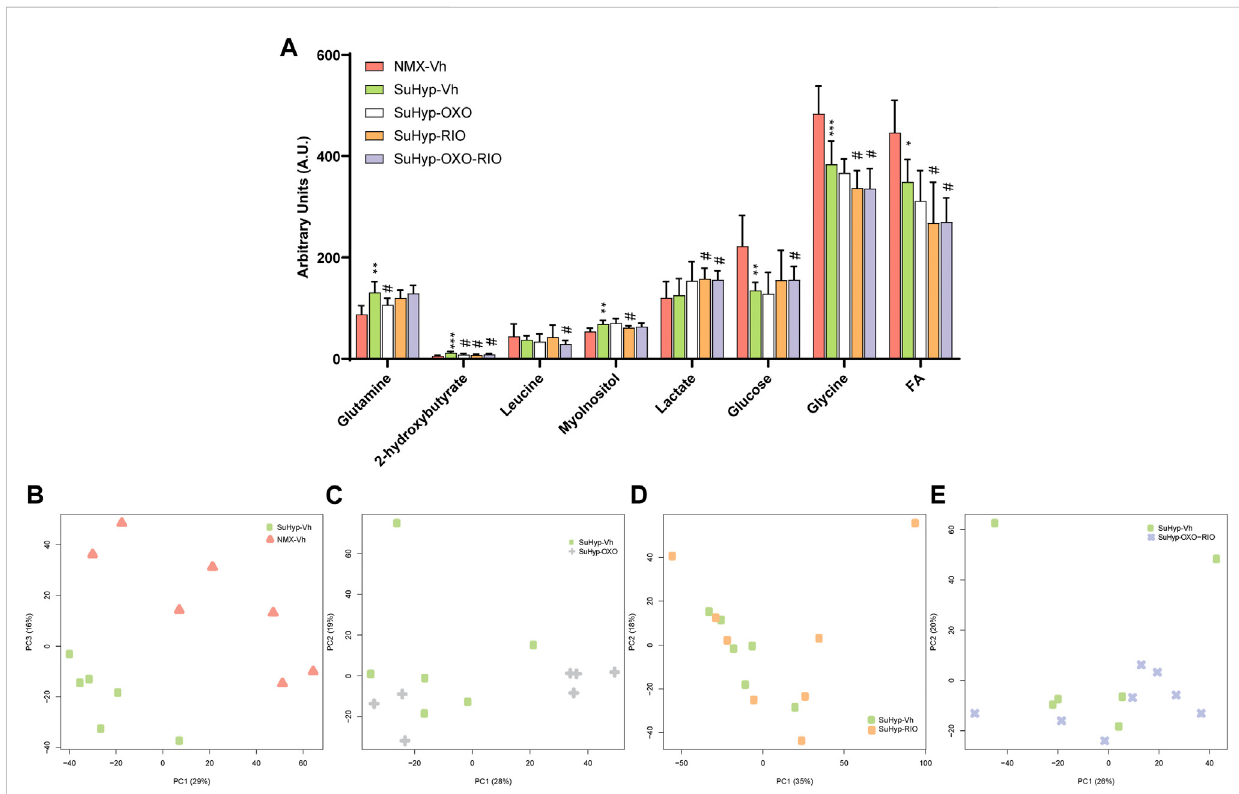
FIGURE 5 Treatment with riociguat and 5-z-7oxozeaenol has a modest effect on the lung metabolic reprogramming in the SuHyp rats. (A) Metabolomic pro fi ling of lung samples showing the quanti fi cation of metabolites signi fi cantly altered between the fi ve intervention groups. Statistical signi fi cance was determined usingaBonferroni-correctedStudent ’ st-test(* p < 0.05 versus normoxiavehicleand# p < 0.05 versus SuHypvehicle). (B) Metabolicpro fi ling of lung samples discriminated between SuHyp and control groups as shown by principal components analysis (PCA) performed on 1 H-MRS data. Treatment with (C) 5Z-7-oxozeaenol, (D) riociguat or (E) both drugs induced a modest effect on the metabolic changes observed in the lungs from SuHPX rats. Control group: NMX-Vh, Sugen 5,416/hypoxia: SuHyp, SuHyp + 5Z-7-oxozeaenol treatment: SuHyp-OXO; SuHyp + riociguat